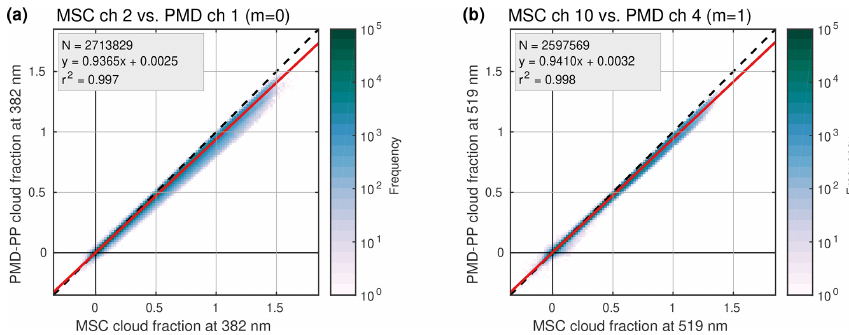
Figure 16. Comparison between MICRU MSC and MICRU PMD cloud fractions for April 2010: (a) at 382nm and (b) at 519nm. The plots correspond to the combinations indicated by circles in Fig.